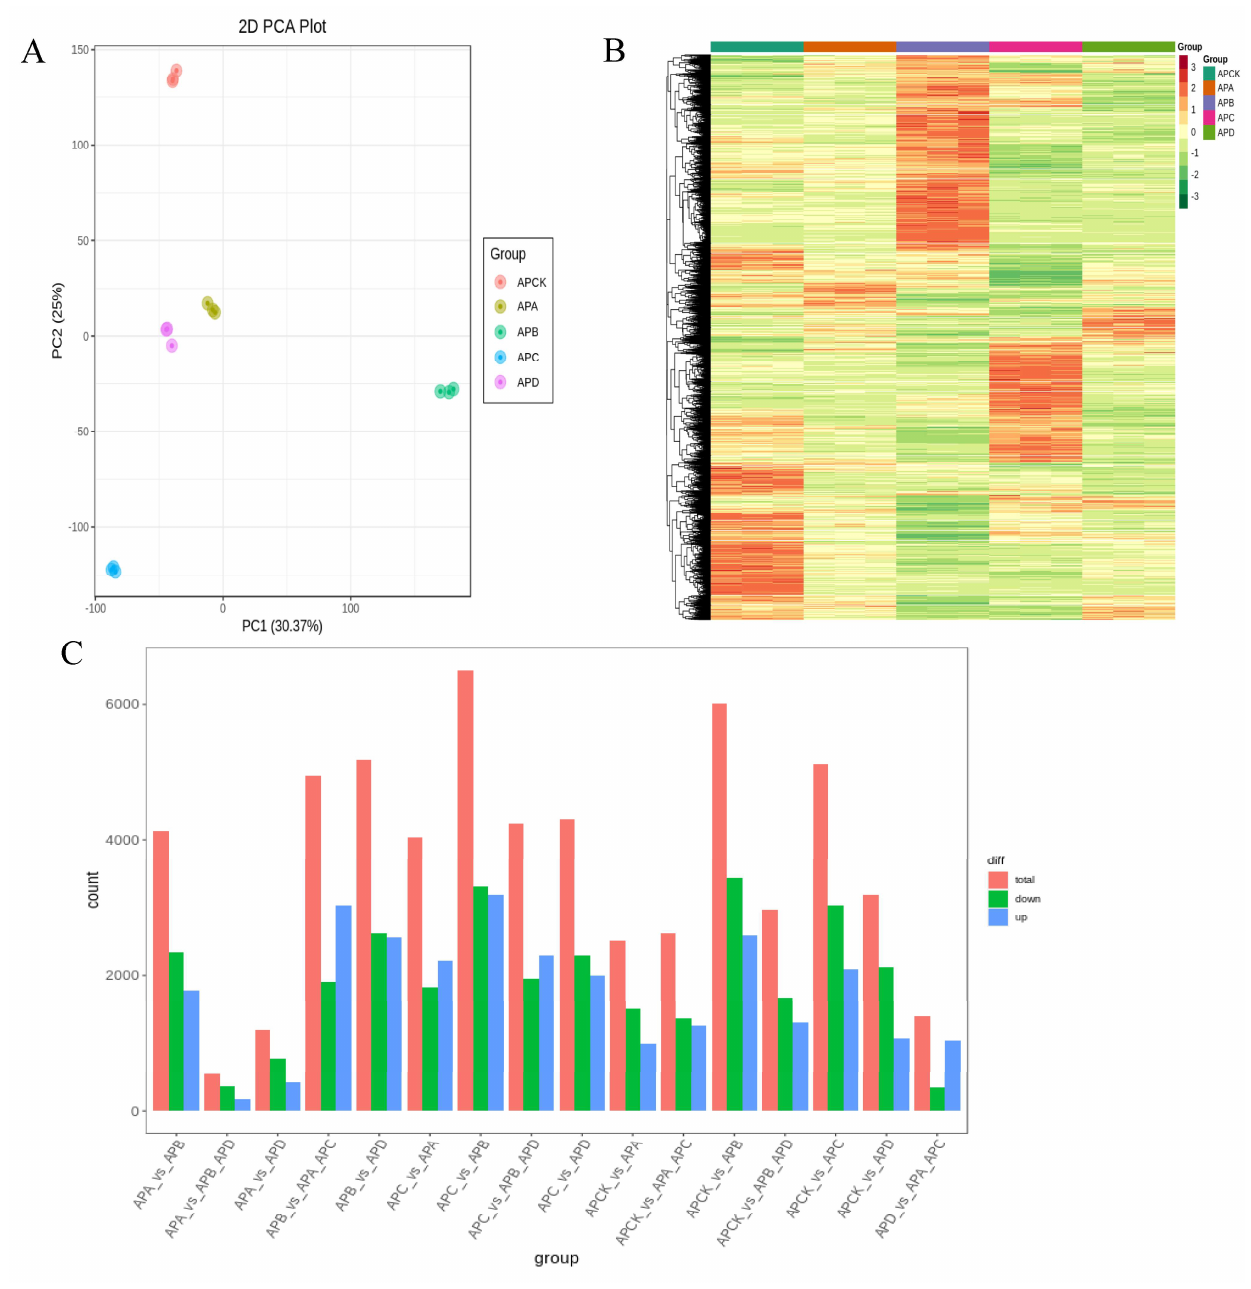
Figure 2 . The number of DEGs caused by freezing of A. pseudosieboldianum at different temperatures. Map An is principal component analysis (PCA), which compresses the original data into five principal components to describe the characteristics of the original data set ( A ). PC1 represents the most obvious features in the multidimensional data matrix, PC2 represents the most significant features in the data matrix except PC1, ( B ) shows the clustering analysis of gene expression in five periods, and ( C ) shows the quantitative expression of differential genes in different periods. APCK, APA, APB, APC, and APD represent A. pseudosieboldianum , 4 °C, −10 °C, −20 °C, −30 °C and −40 °C, re- spectively.